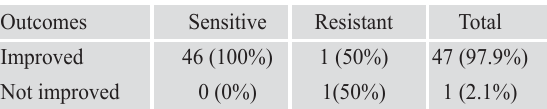
Table IV: Outcomes of treatment in ceftriaxone group based on